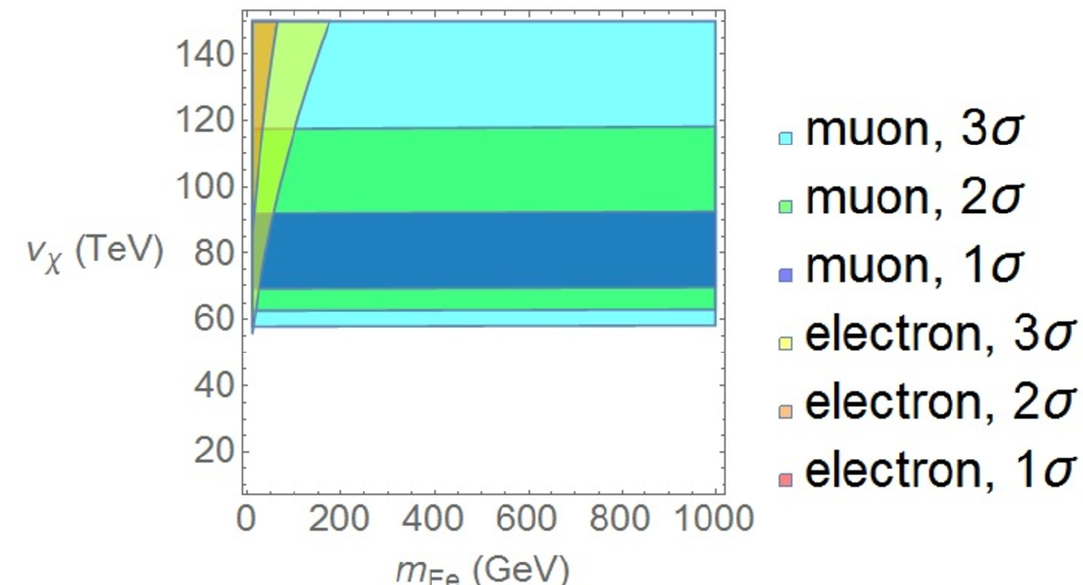
Figure 12 . v (cid:31) and m E values satisfying eq. (3.1) within 1 (cid:27) , 2 (cid:27) and 3 (cid:27) . Here we used the third e set of diagonalization matrices (see section 4.2.4) and considered: m E and m = m = m = 1000 (all in GeV). The masses of the exotic gauge bosons ( U (cid:6)(cid:6) and A 0 Y ++ Y + 1 Z 0 ) have their values de(cid:12)ned by the value of v (cid:31) , since its other parameters are already (cid:12)xed (see [37] for details). Figure 13 . Same as in (cid:12)gure 12 but now with m E